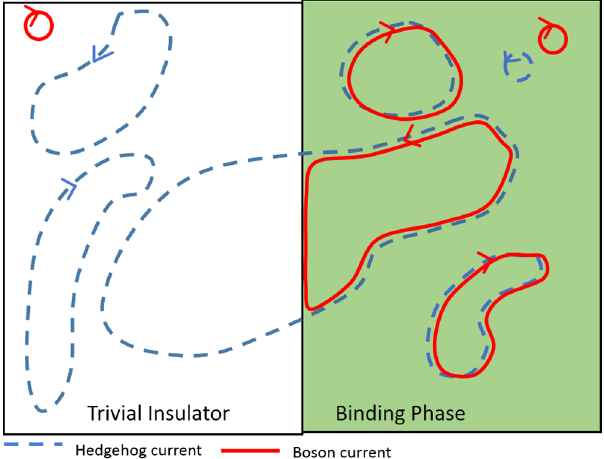
FIG. 3. A snapshot of the system, when it is spatially divided into a region that is a trivial insulator and a region that is in the binding phase. In the trivial phase, boson currents are gapped and hedgehog currents are proliferated. In the binding phase, both currents are gapped individually, but their bound states are proliferated. Large hedgehog current loops can exist in either region; however, when such a loop tries to cross the boundary, the conservation of boson current leads to a conflict between the two sides, and this can lead to exotic surface